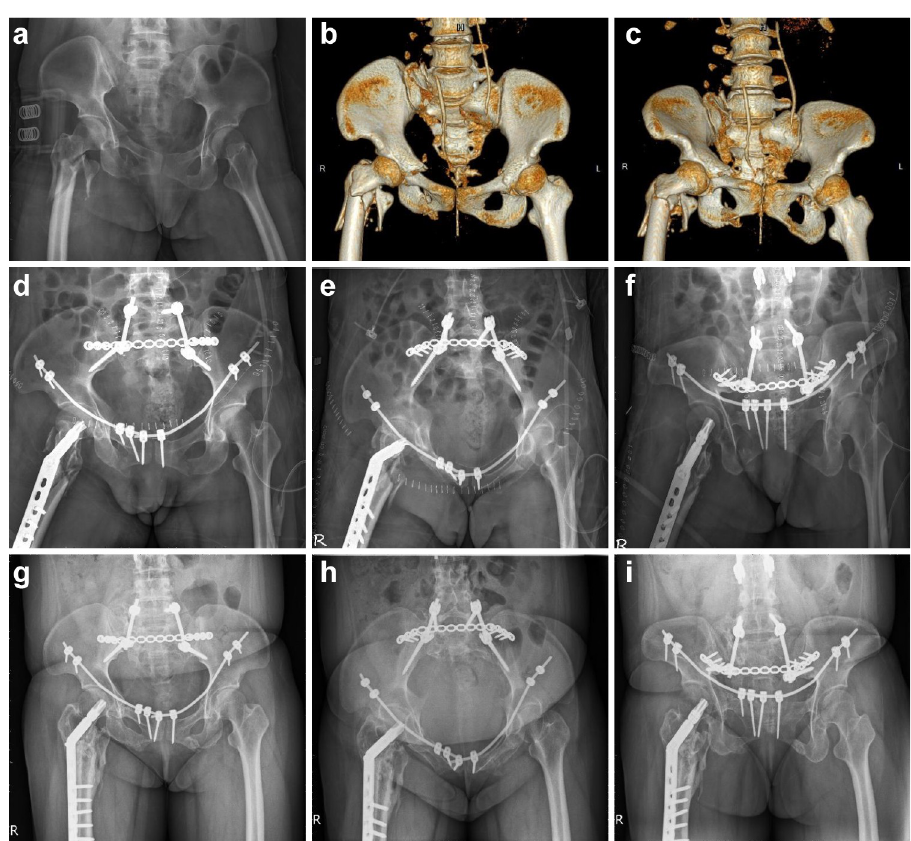
Fig 3. A 37-year-old female with anterior and posterior pelvic ring injury. a Preoperative pelvic anterior-posterior (AP) view. b Preoperative 3D reconstructed computed tomography (CT) AP view. c Preoperative 3D reconstructed CT outlet view showing a U-shape sacral fracture with bilateral superior and inferior pubic rami fractures and comminuted right proximal femur fracture. d, e, f Postoperative pelvic radiology series (AP, inlet, outlet view) demonstrating spinopelvic and transiliac plate fixation of the posterior pelvic ring fracture, bilateral MPSRF of the anterior pelvic ring fracture, and dynamic hip screw fixation of the right proximal femur. g, h, i Postoperative pelvic radiology series (AP, inlet, outlet view) at 13-month follow-up, demonstrating bone union of the pelvic ring. The quality of fracture reduction was graded as